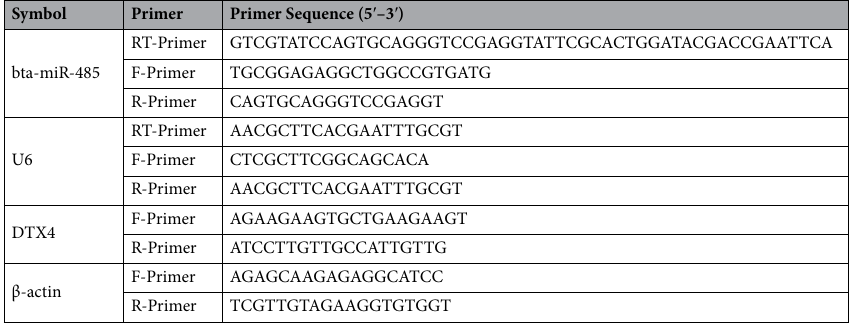
Table 1. Real-time PCR primer sequences.